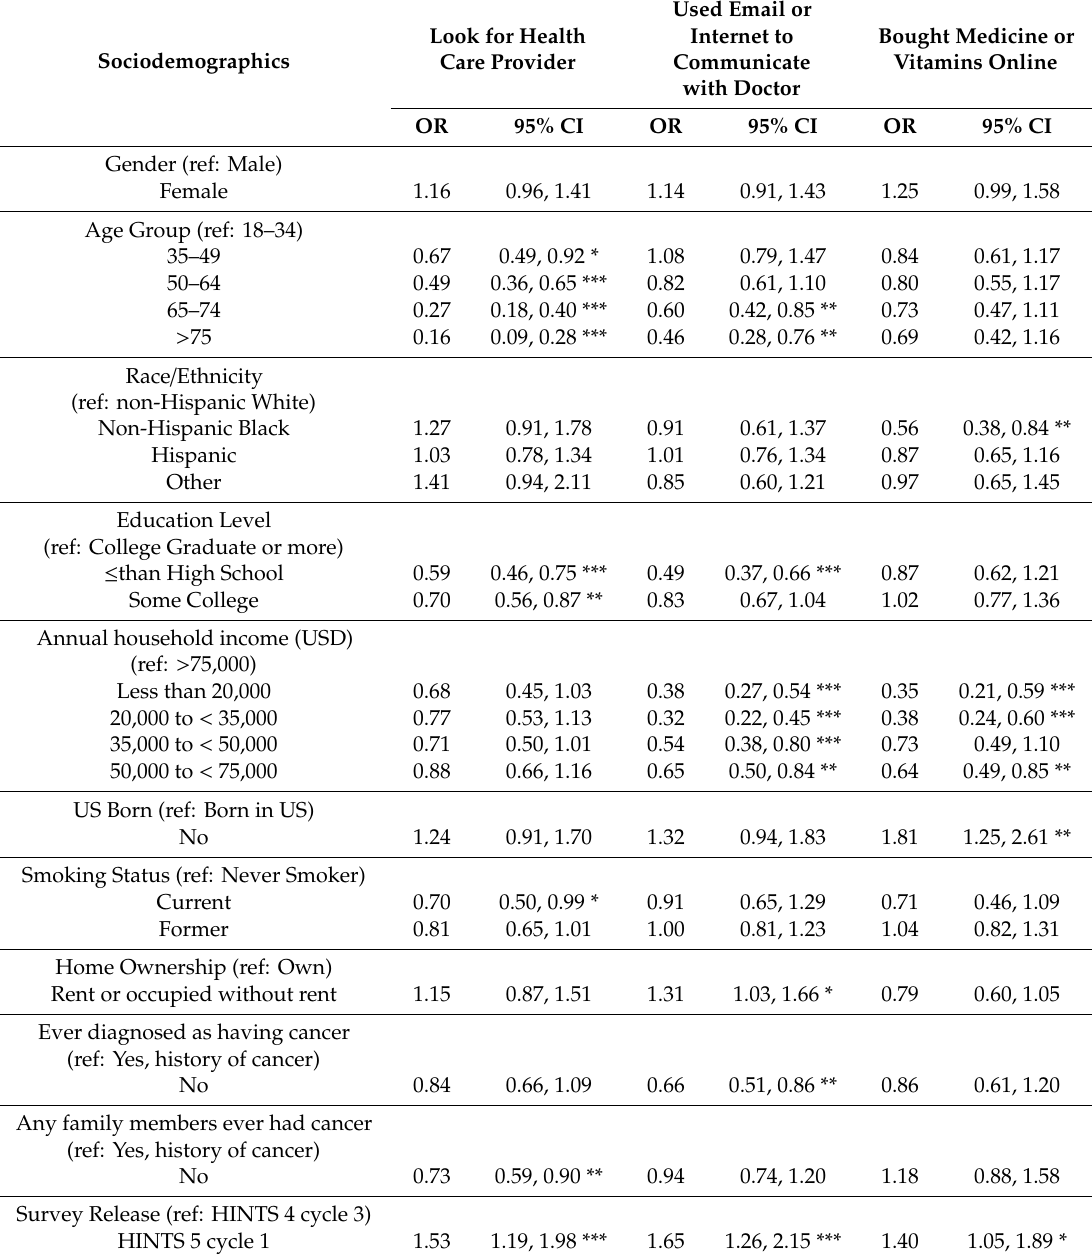
Table 3. Results of multivariable logistic regression models for healthcare domain outcomes ( N = 4817). Sociodemographics